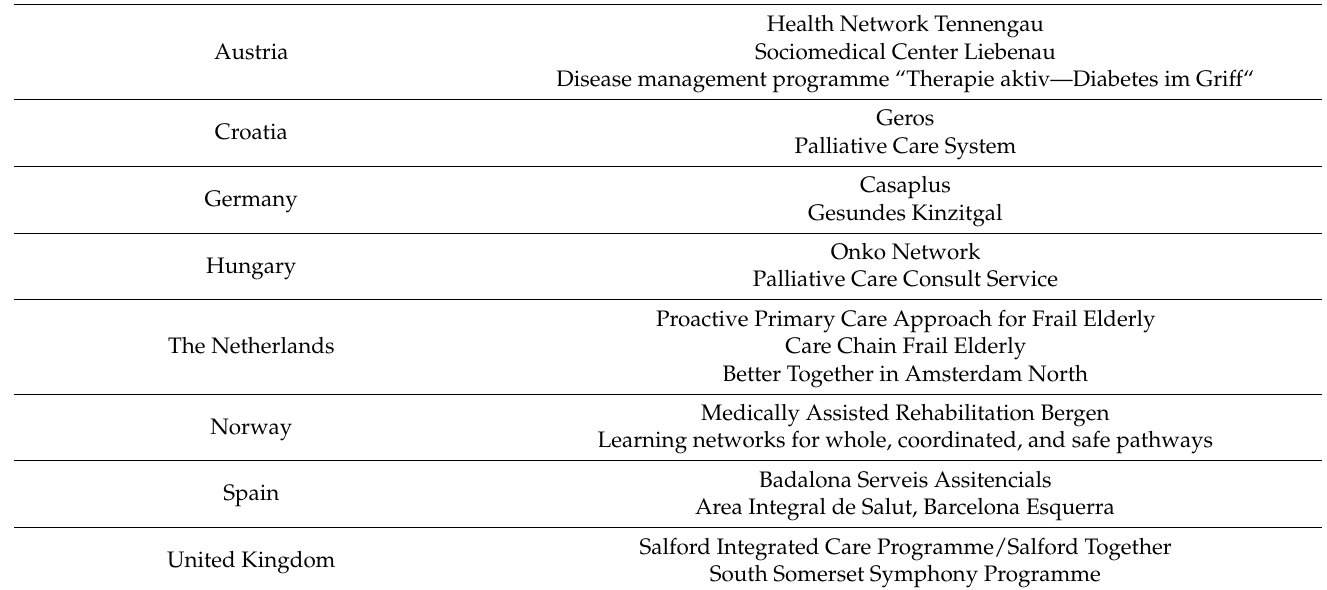
Table 1. Overview of national and international integrated care programs (own presentation; data from Institute for Advanced Studies Austria 2016